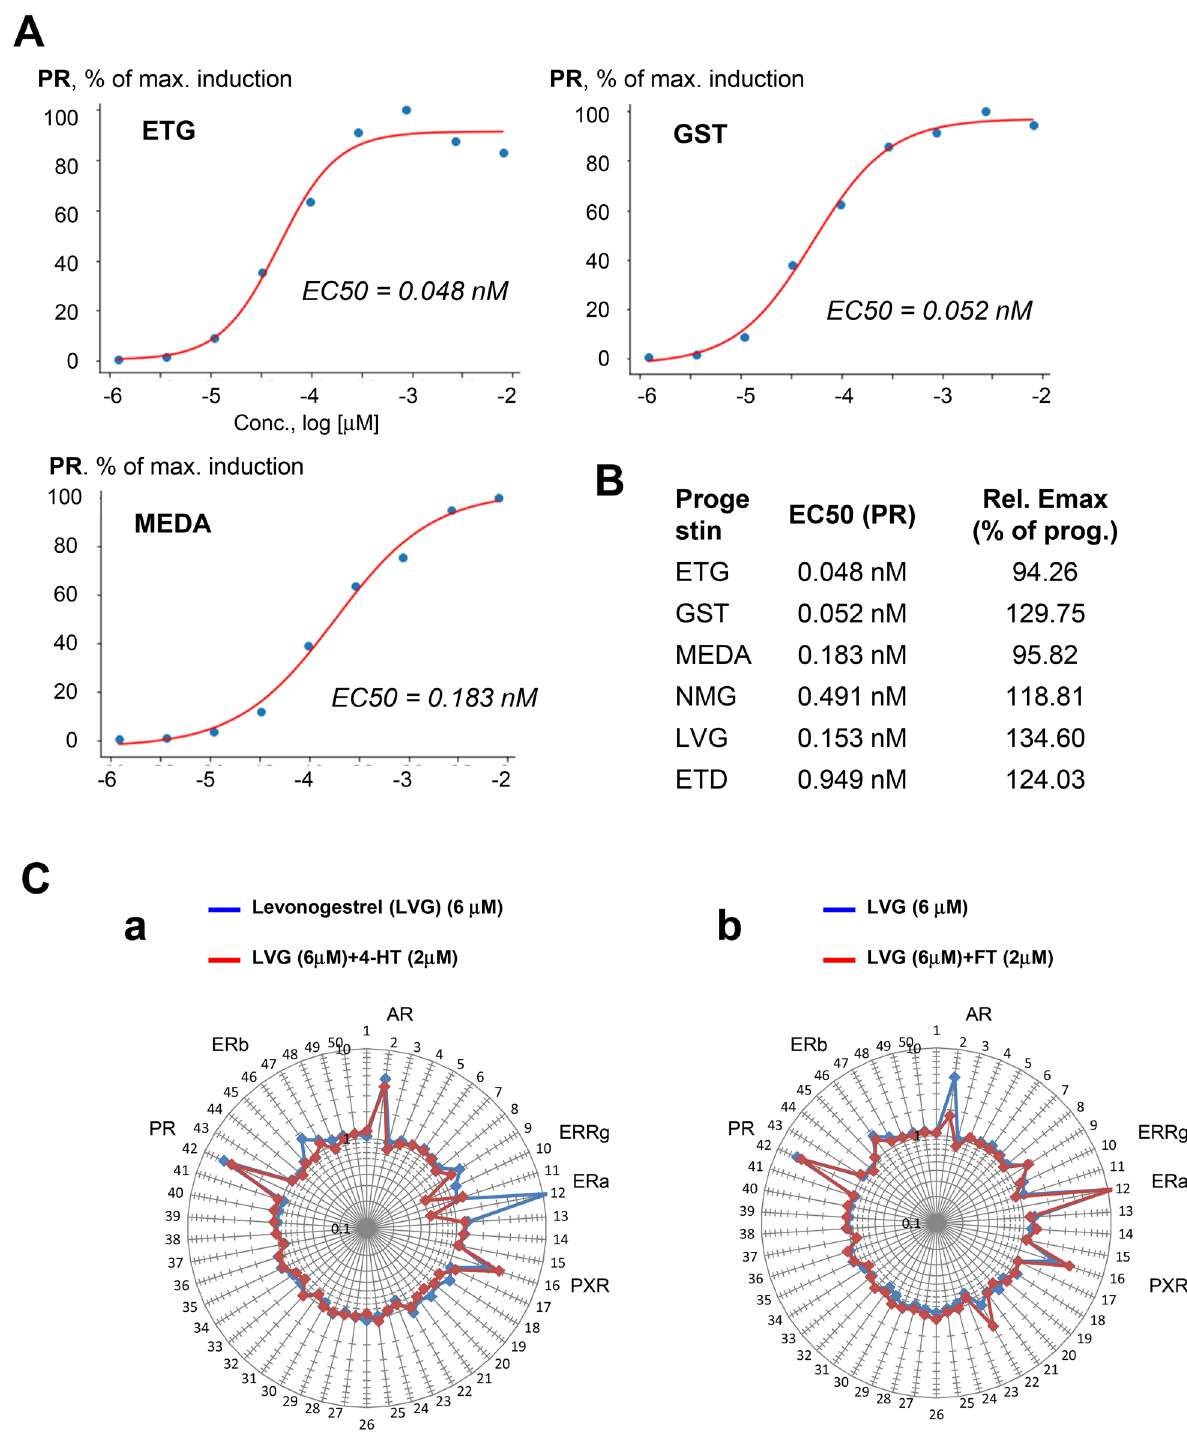
Figure 7. Evaluating the NR activity of progestins. (A) The concentration–response of progestins’ primary target (the PR). The data shown as the percentage of the maximal PR activation by the progestins. Average data of three independent replicate FACTORIAL NR assays are shown. ( B) The inferred EC50 values for the primary progestin activity. ( C) A competitive mode assay to assess off-target activity mechanisms. The graphs show log-transformed NR activity fold-changes (in progestin- vs. vehicle-treated cells) after a 24-h treatment with LVG. Blue line shows the NR activity profile for LVG. Red line : the NR activity profile for LVG in the presence of ER inhibitor 4-HT ( a ) or AR inhibitor FT ( b ). Each is the average profile of three independent replicate FACTORIAL NR